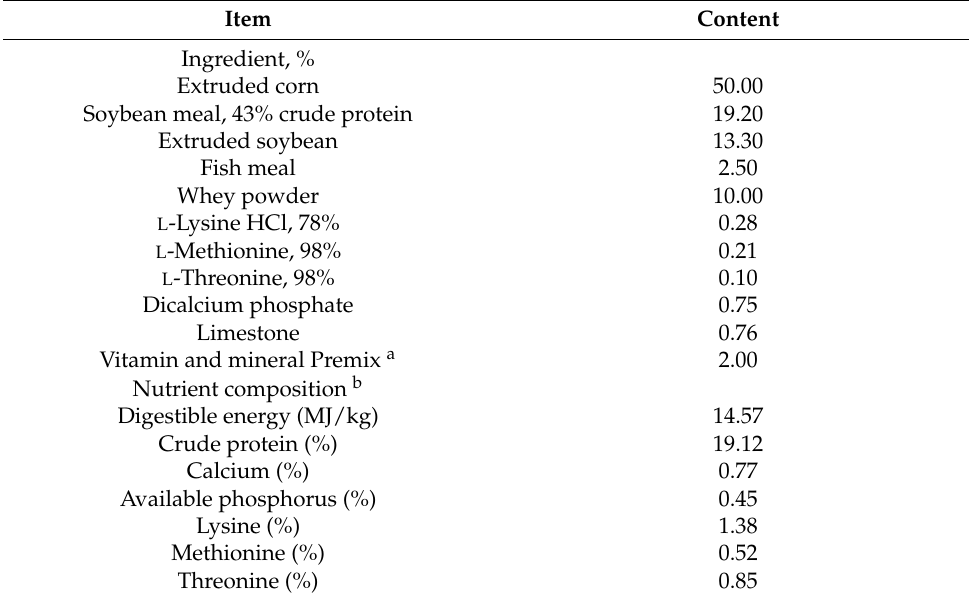
Table 1. Ingredient composition of the basal diet (on an as-fed basis)